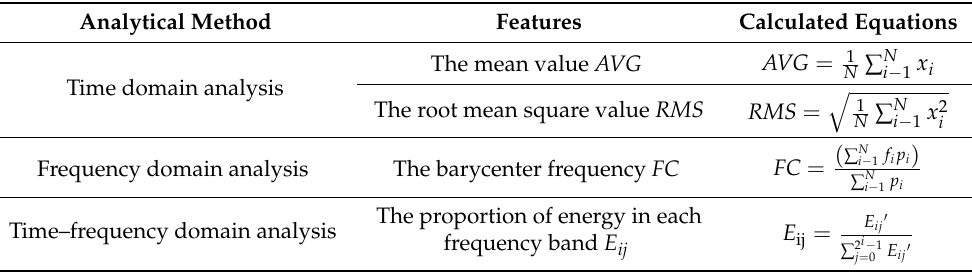
Table 2. Relevant features of grinding wheel